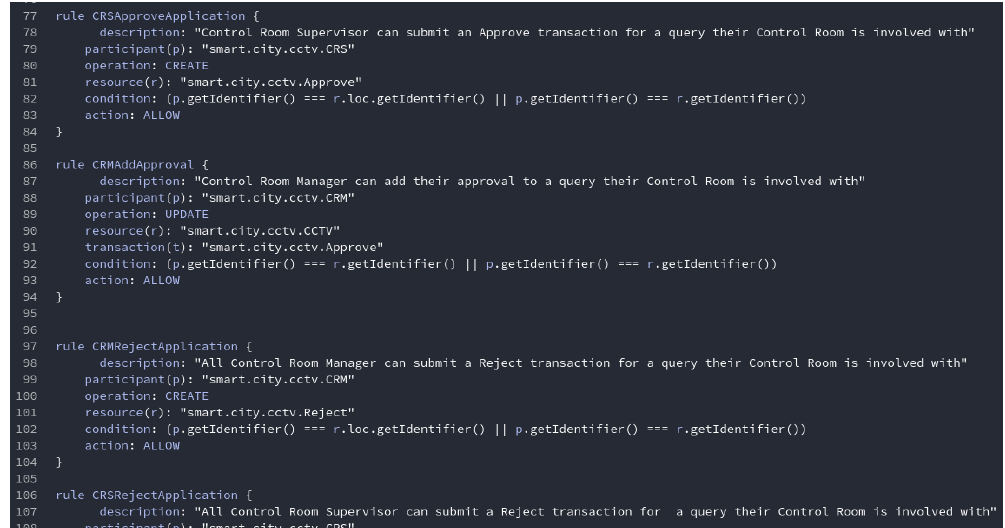
Figure 14. Transaction control rules in the smart